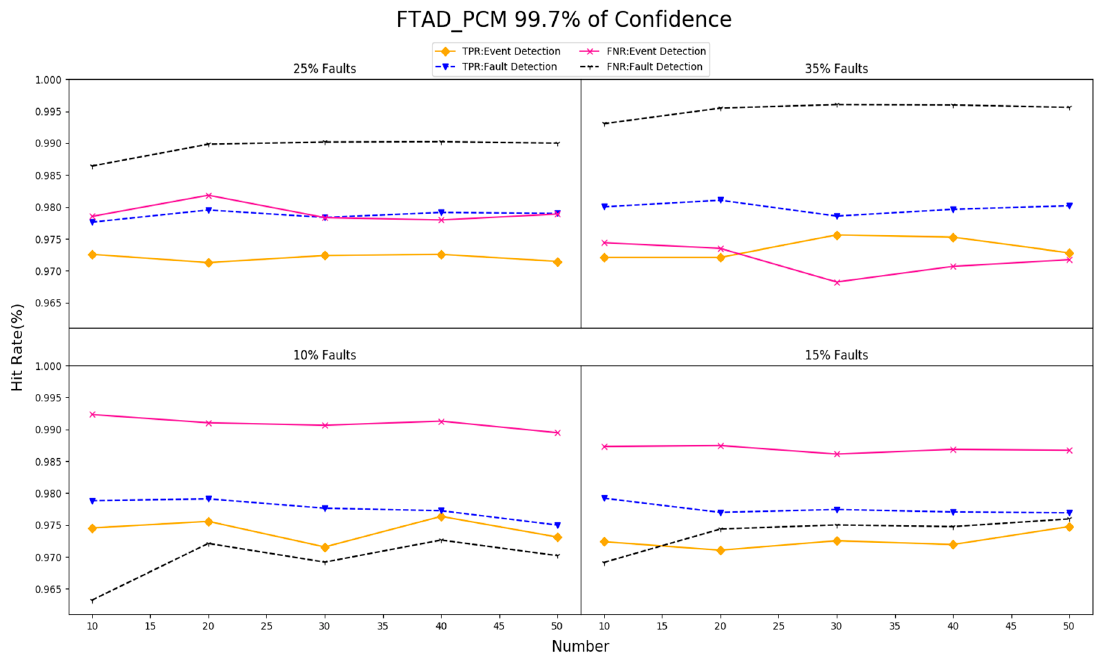
Figure 3. FTAD_PCM with 99.7% confidence.